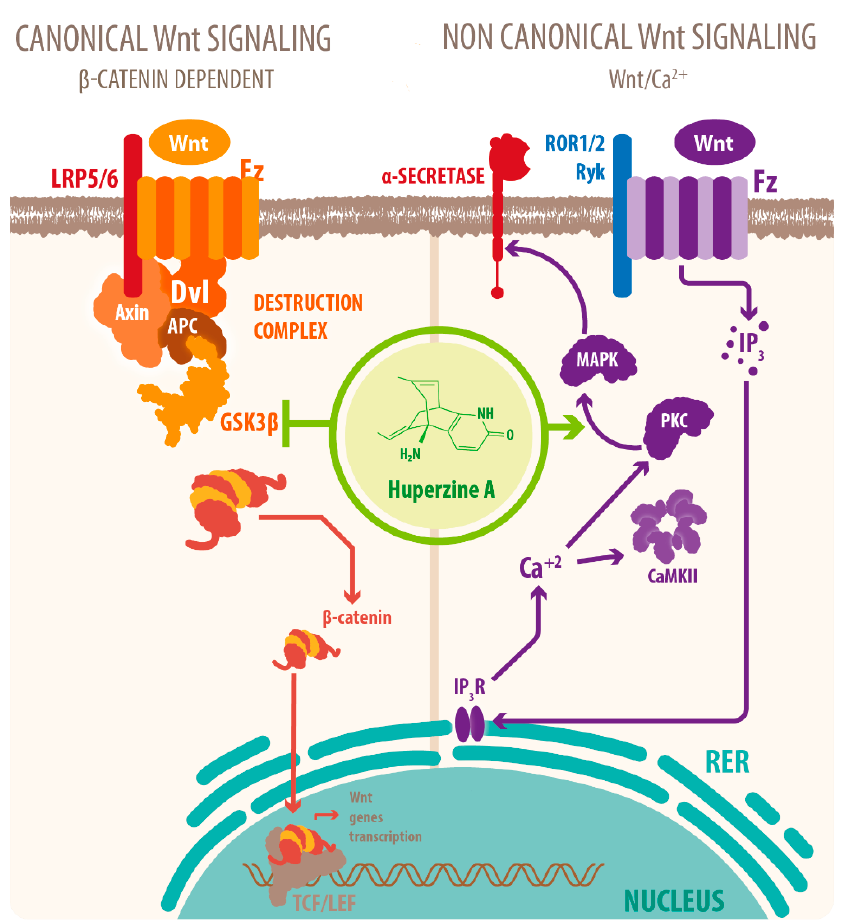
Figure 4. HupA affects Wnt signaling. HupA affects both canonical and noncanonical Wnt signaling. Regarding the canonical signaling, HupA modulates the Wnt/ β -catenin pathway by downregulating GSK-3 β activity. HupA increases the phosphorylation levels of GSK-3 α / β , which stabilizes β -catenin and upregulates expression of its target genes, related to synaptic plasticity and neuronal survival, while preventing tau hyperphosphorylation and A β neurotoxicity. HupA also interacts with the noncanonical pathway via PKC/MAPK signaling. PKC activation also inhibits GSK-3 β activity and plays a role in upregulating the expression of the α -secretase, preventing A β accumulation and neuronal apoptosis (Wnt: wingless-related integration site; GSK3: glycogen synthase kinase 3; PKC: protein kinase C; MAPK: mitogen-activated protein kinase).